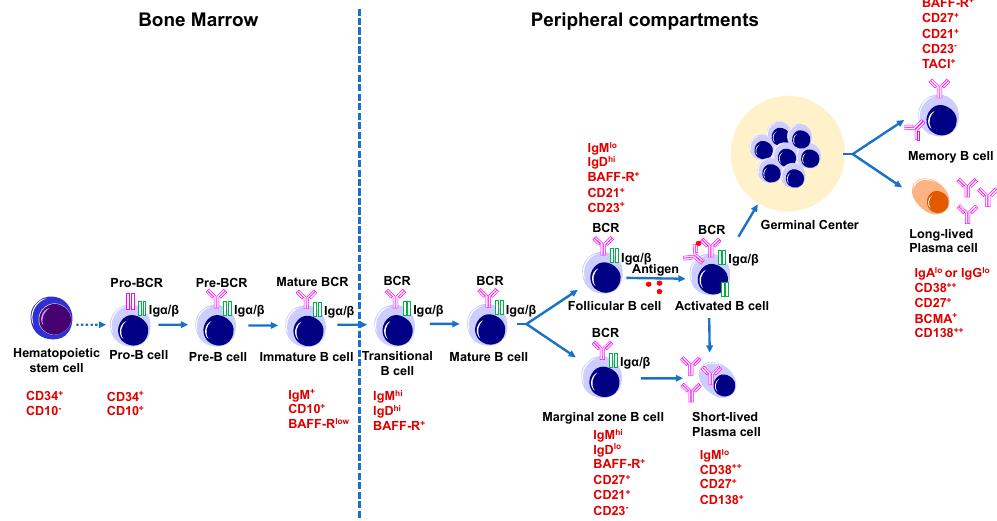
Figure 2. B cell development and maturation. B cells originate from hematopoietic stem cells in the bone marrow. Hematopoietic stem cell di ff erentiates into common lymphoid progenitor cell, which give rise to a B lymphocyte progenitor that then di ff erentiates into a Pro-B cell (CD34 + CD10 + ), and a Pre-B cell, and then an immature B cell (IgM + CD10 + BAFF-R low ). In the spleen, immature B